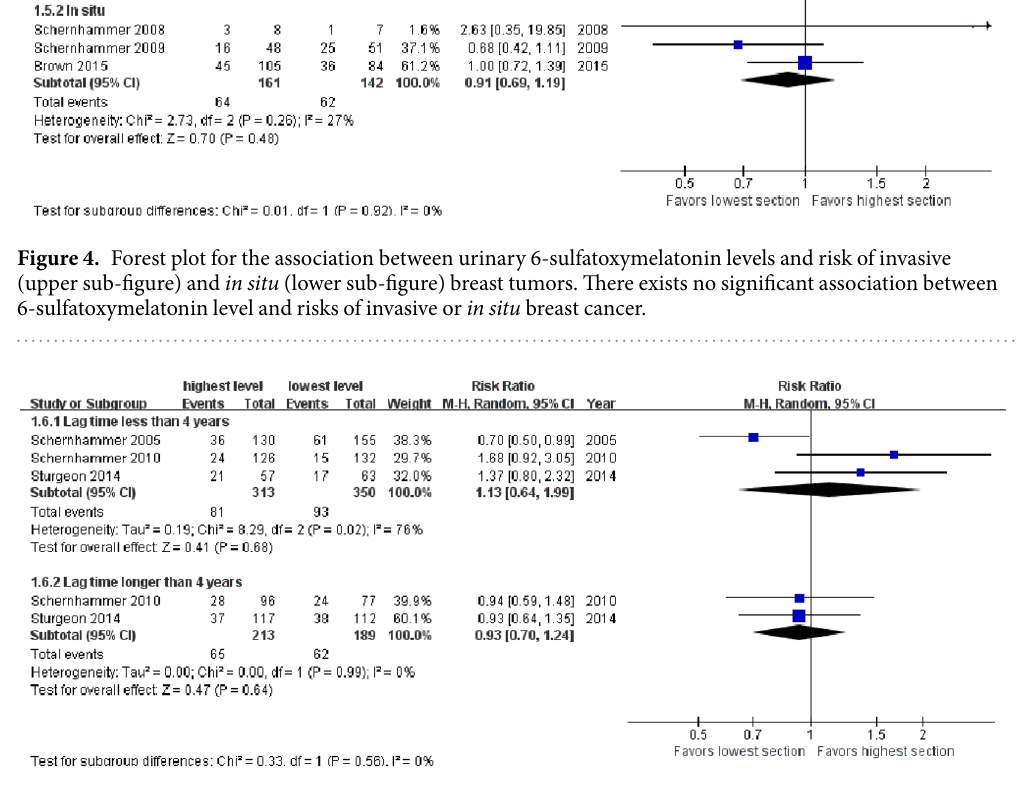
Figure 5. Forest plot for the association between urinary 6-sulfatoxymelatonin levels and breast cancer risk with lag time of less (upper sub-figure) and longer (lower sub-figure) than 4 years. For both kinds of lag time, no significant associations are detected.